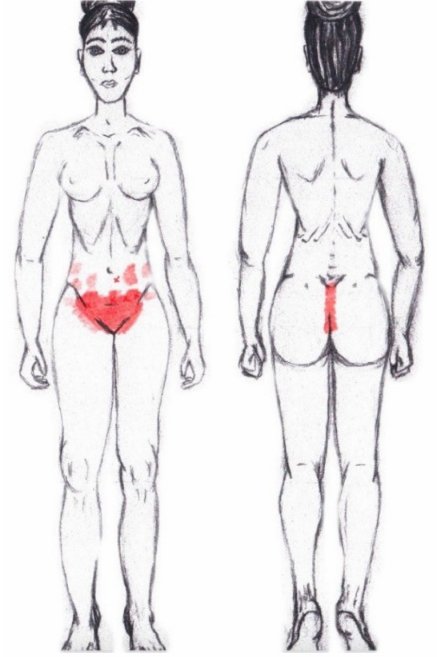
Figure 6. Graphical simulation of referred pain areas of the internal oblique